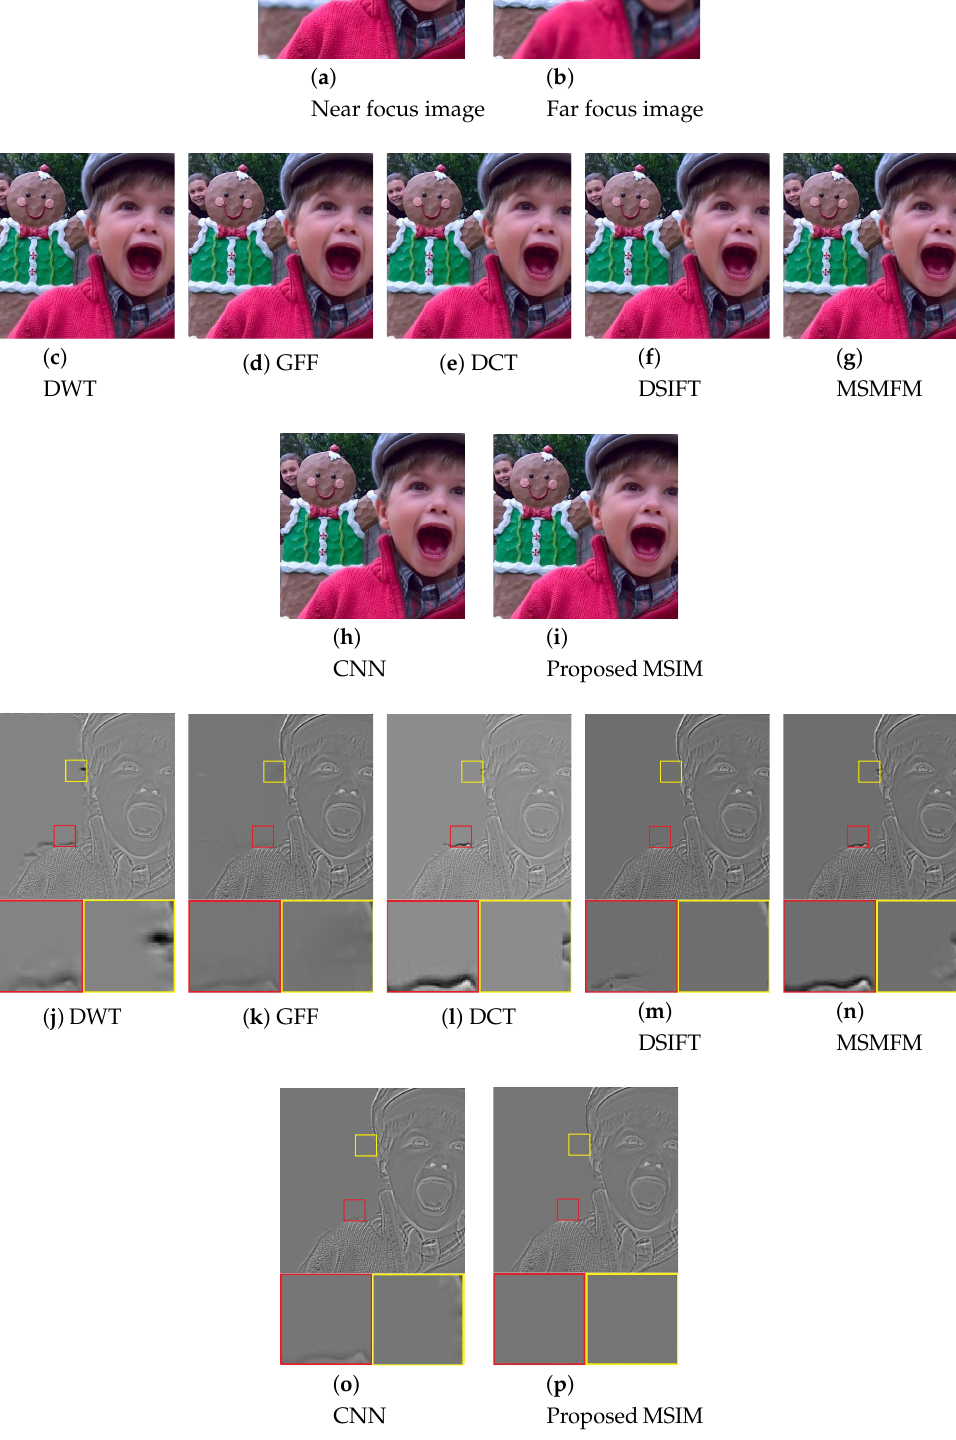
Figure 7. Results of image fusion and their difference images on the “Boy” source images. ( c – i ) Fused images obtained through fusion schemes. ( j – p ) Difference images obtained from the fusion results and Figure